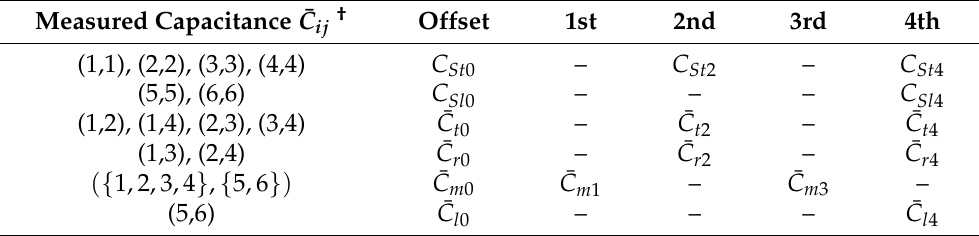
Table 1. Identified offsets and harmonic amplitudes used in the definition of the equations that compose the capacitance